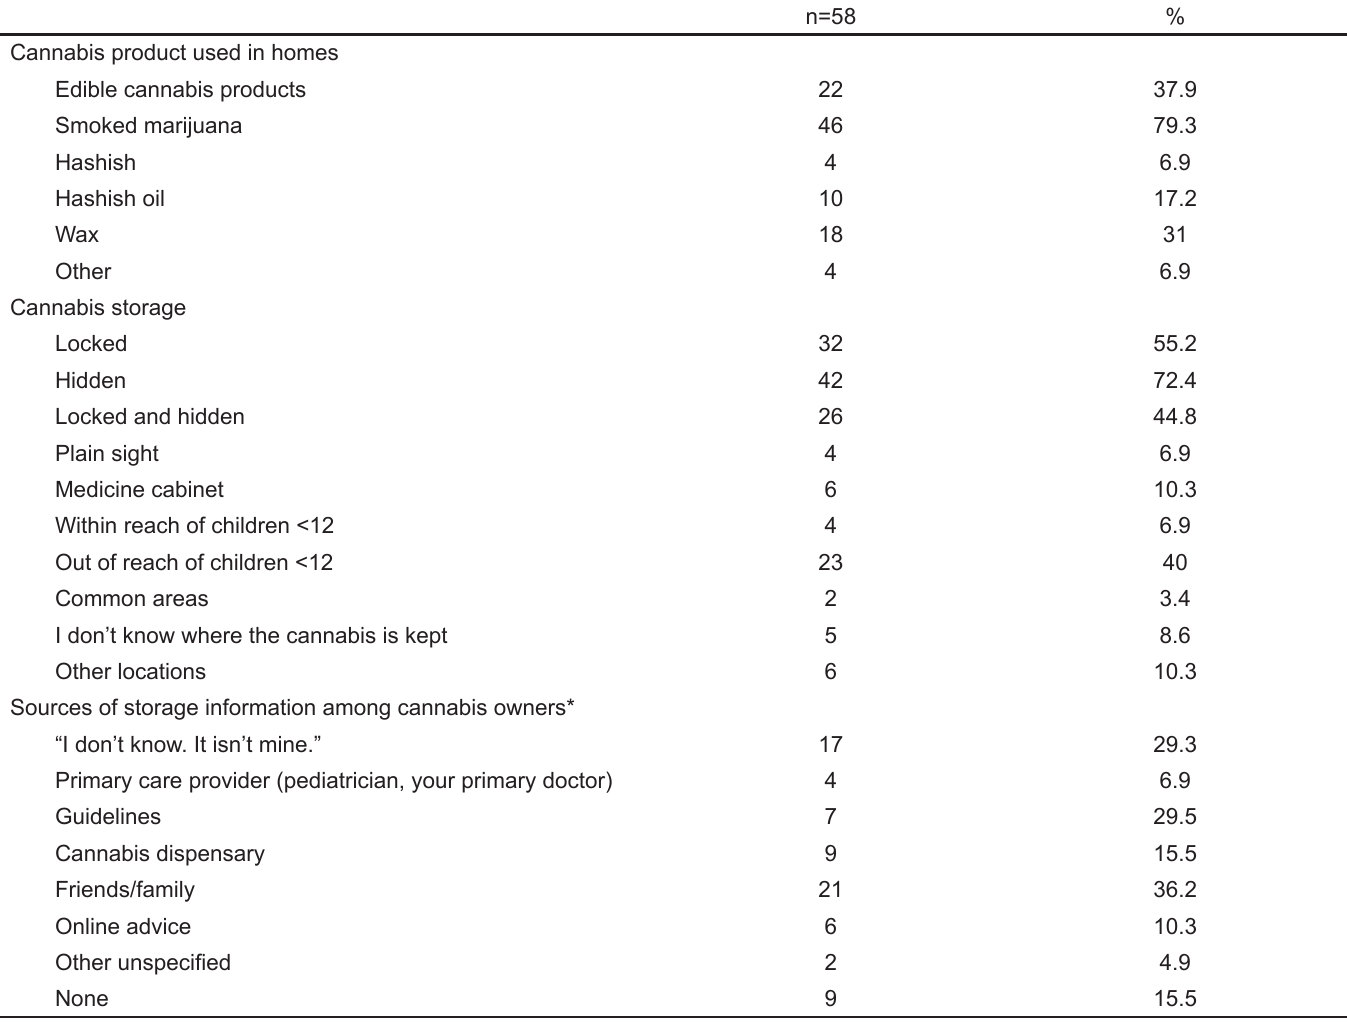
Table 2. Cannabis users’ products, storage practices, and sources of storage